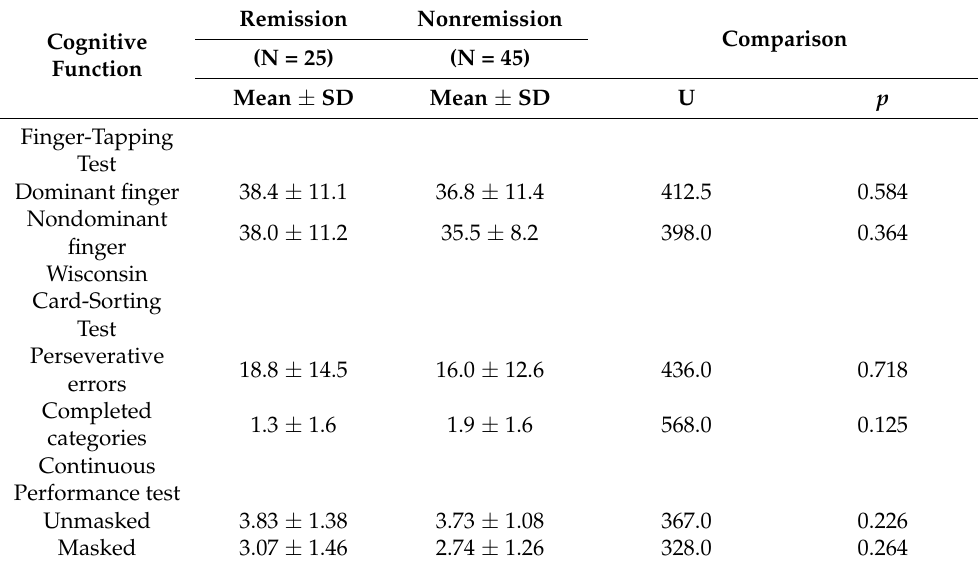
Table 3. Cognitive function of the remission and nonremission